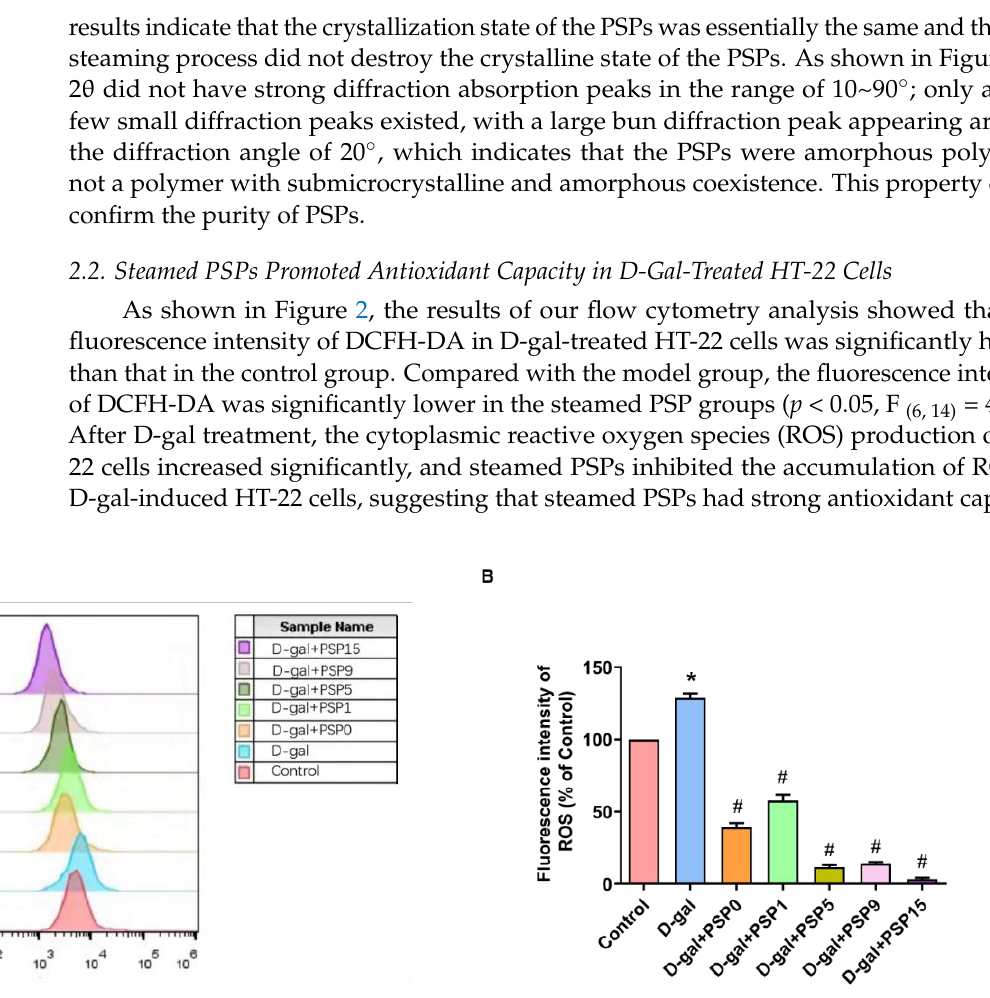
Figure 2. Steamed PSPs increase the antioxidant capacity of D-gal-induced HT-22 cells. ( A ) Fluores- cence intensity of ROS; ( B ) effects of PSP on ROS of HT-22 cells (hippocampal neuron of mice). Data are expressed as means ± SEM. * p < 0.05 vs. Control, # p < 0.05 vs. D-gal.